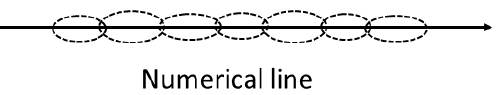
Figure 6. Representation of a numerical line as a chain of intersected spots.